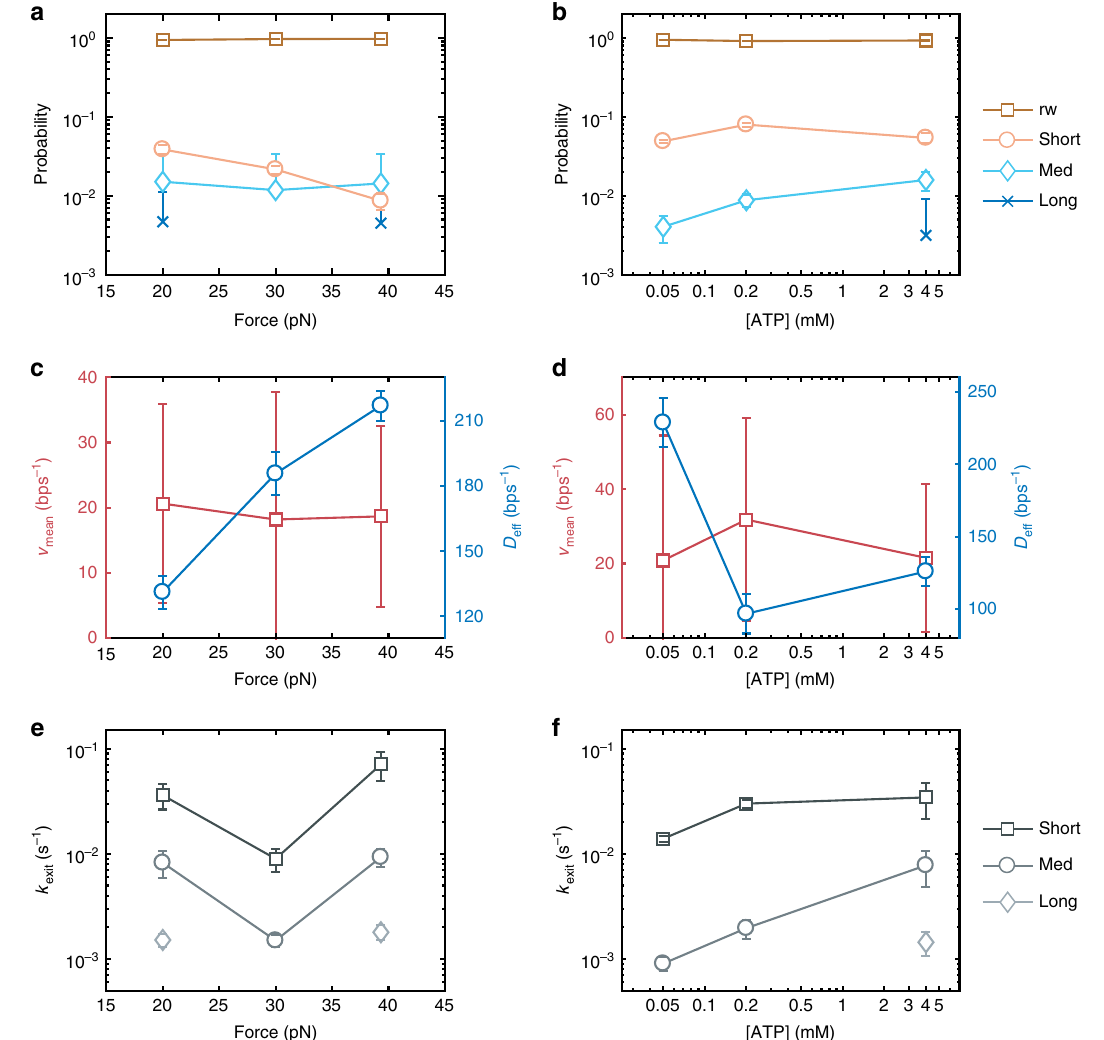
Fig. 4 Model parameters of Eq. 2 extracted from maximum likelihood estimation of experimentally measured fi rst-passage times for varying force and ATP concentration. Probability of entering the biased random walk state (brown squares), a short (orange circles), medium (cyan diamonds), or a long (blue crosses) timescale pause as a function of a force and b ATP concentration. Mean velocity (red sqaures) and effective diffusion (blue circles) as a function of c force and d ATP concentration. Rate of exit from short (dark grey sqaures), medium (grey circles) or long (light grey diamonds) timescale pause as a function of e force and f ATP concentration. All error bars are standard deviations from 1000